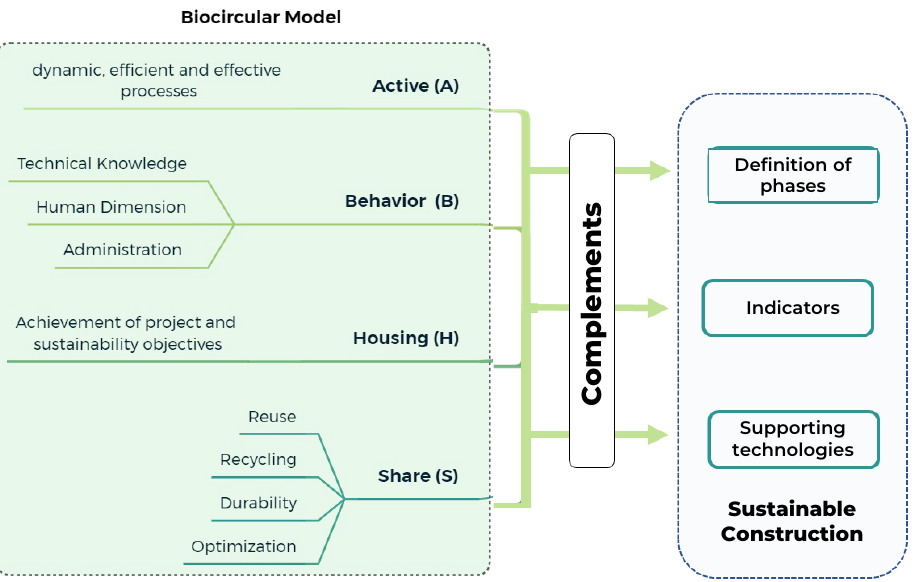
Figure 10. Biocircular model and its influence on sustainable